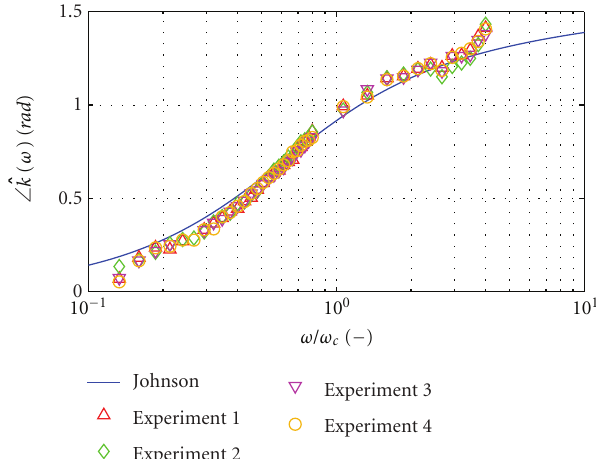
Figure 5: Amplitude of the normalized dynamic permeability. Theory of Johnson et al. [59] versus measurements, using the para- meters as shown in Table 1. Experiments 1–4 denote repeated experiments at di ff erent times.